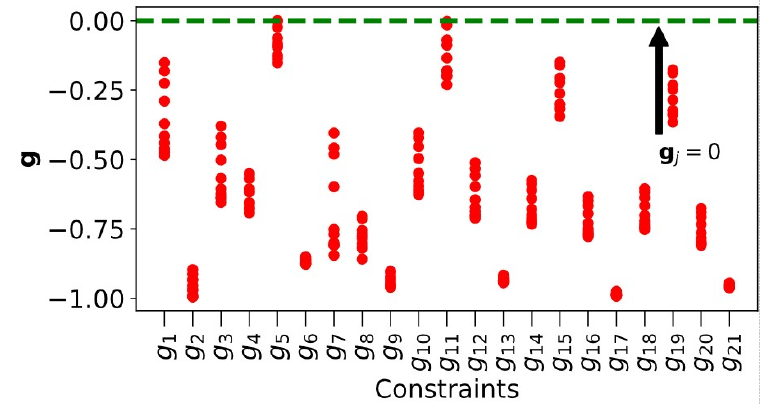
Figure 7. Evaluation of the constraints for the optimal response in simulations 01 to